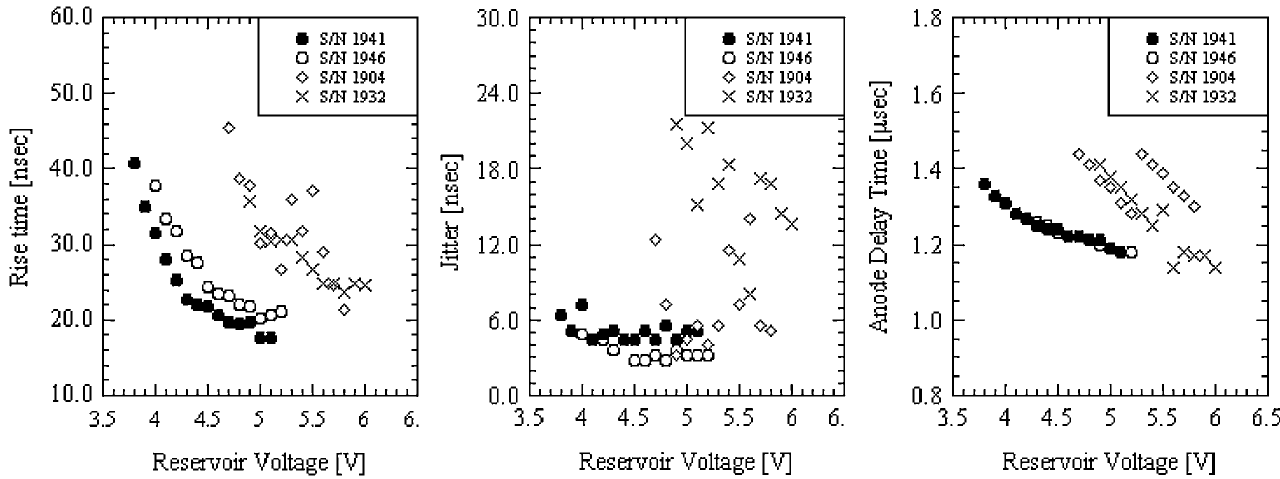
FIG. 10. Dependence of rise time, jitter, and anode delay time on reservoir